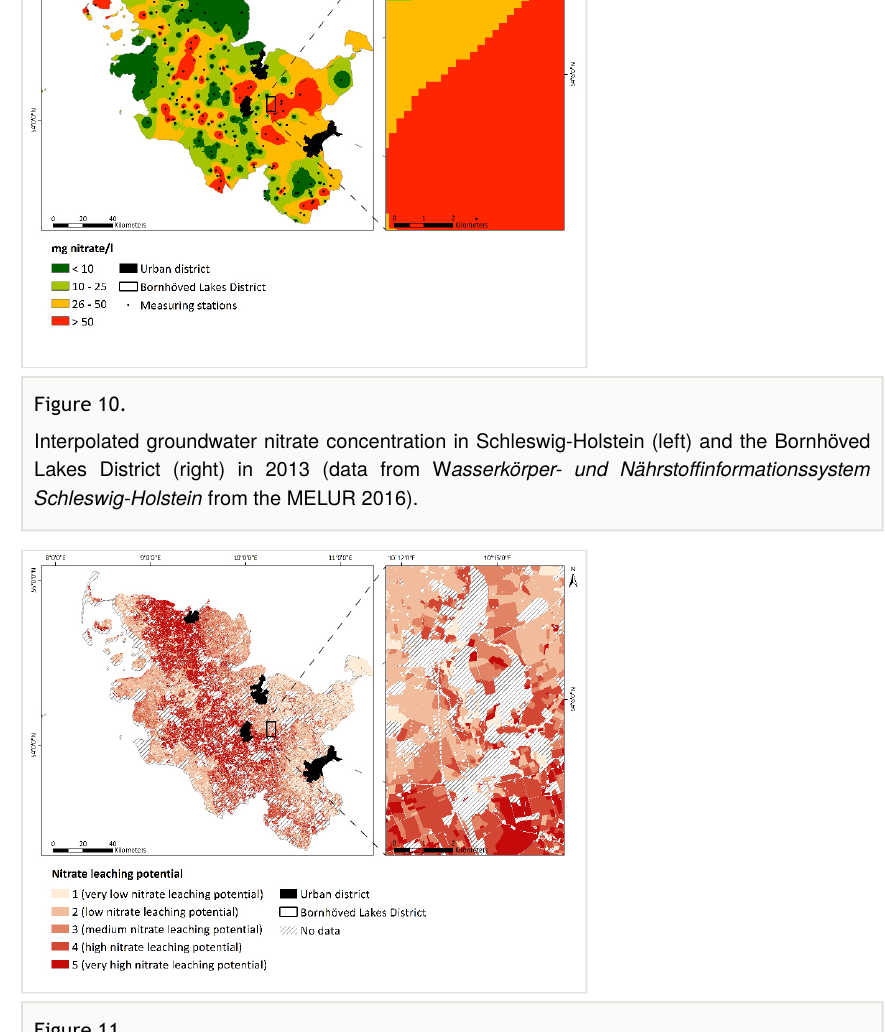
Figure 11. Nitrate leaching potentials in Schleswig-Holstein (left) and the Bornhöved Lakes District (right) (data from LLUR